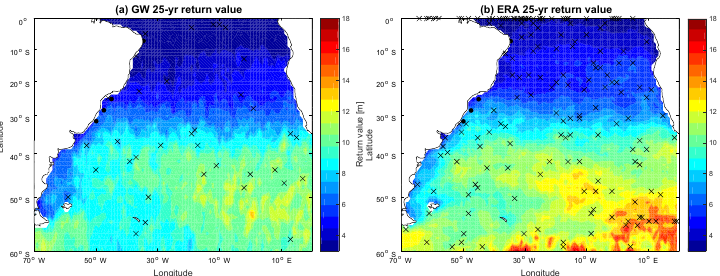
Figure 8. Distribution of 25-year return values from interpolated LOS data (a) and from ERA-Interim (b) in the South Atlantic. Crosses represent the series that did not pass the Kolmogorov–Smirnov test.